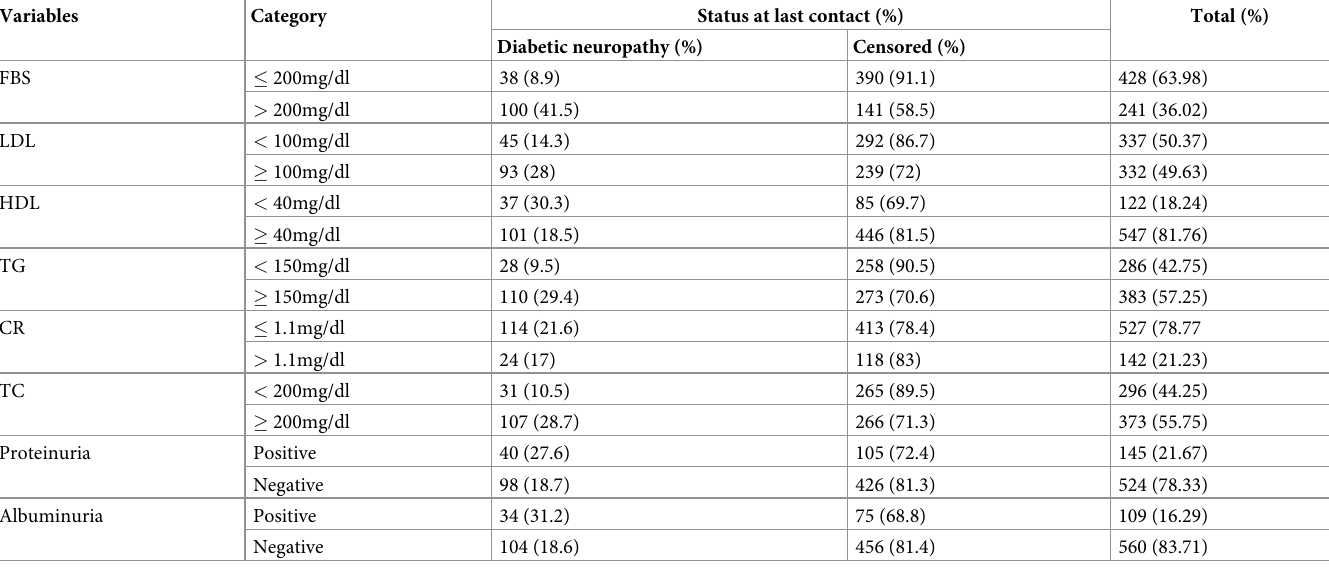
Table 3. Biochemical characteristics of type 2 DM patients at Amhara region Comprehensive Specialized Hospital, Northwest Ethiopia (n = 669).